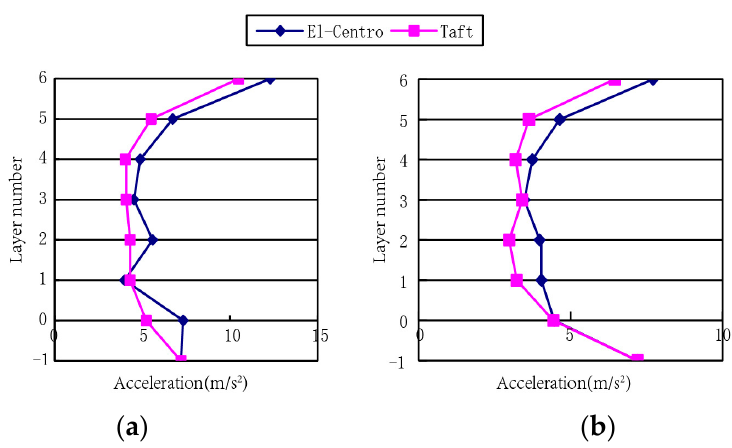
Figure 12. The peak acceleration (0.72 g). ( a ) Continuous control; ( b ) switch control.